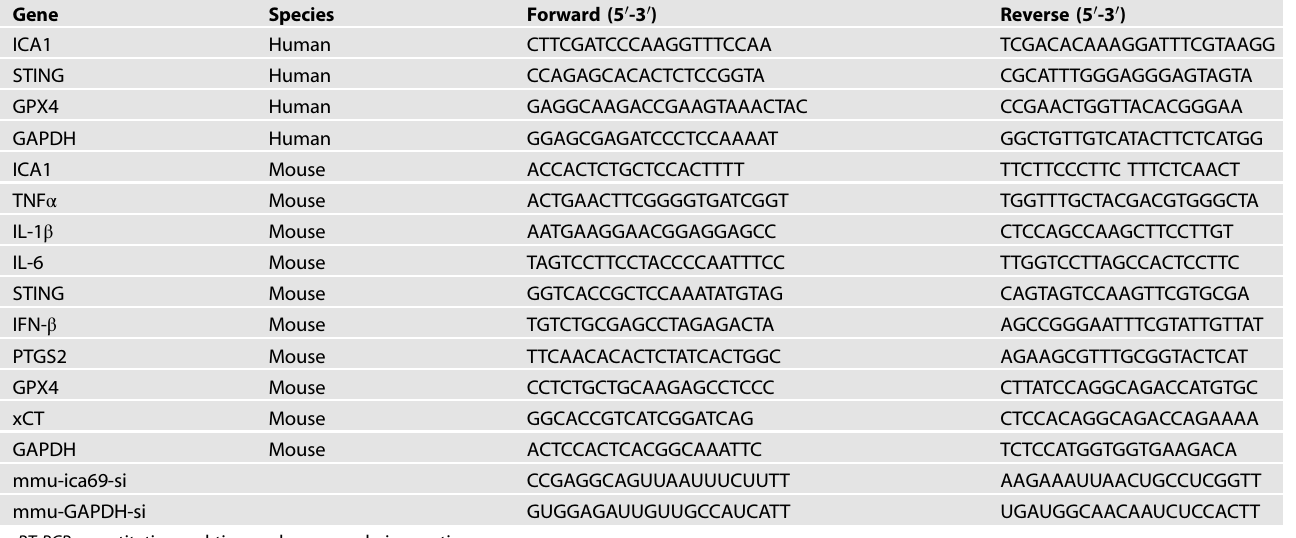
Table 2. Primers used for qRT-PCR/sequence of